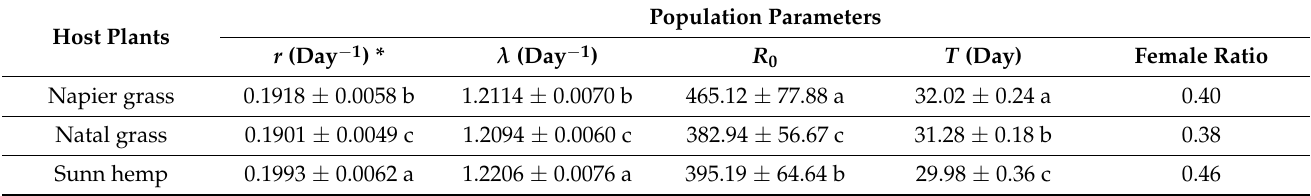
Table 2. Population parameters (mean ± SE) and female ratio of FAW on different host plants.